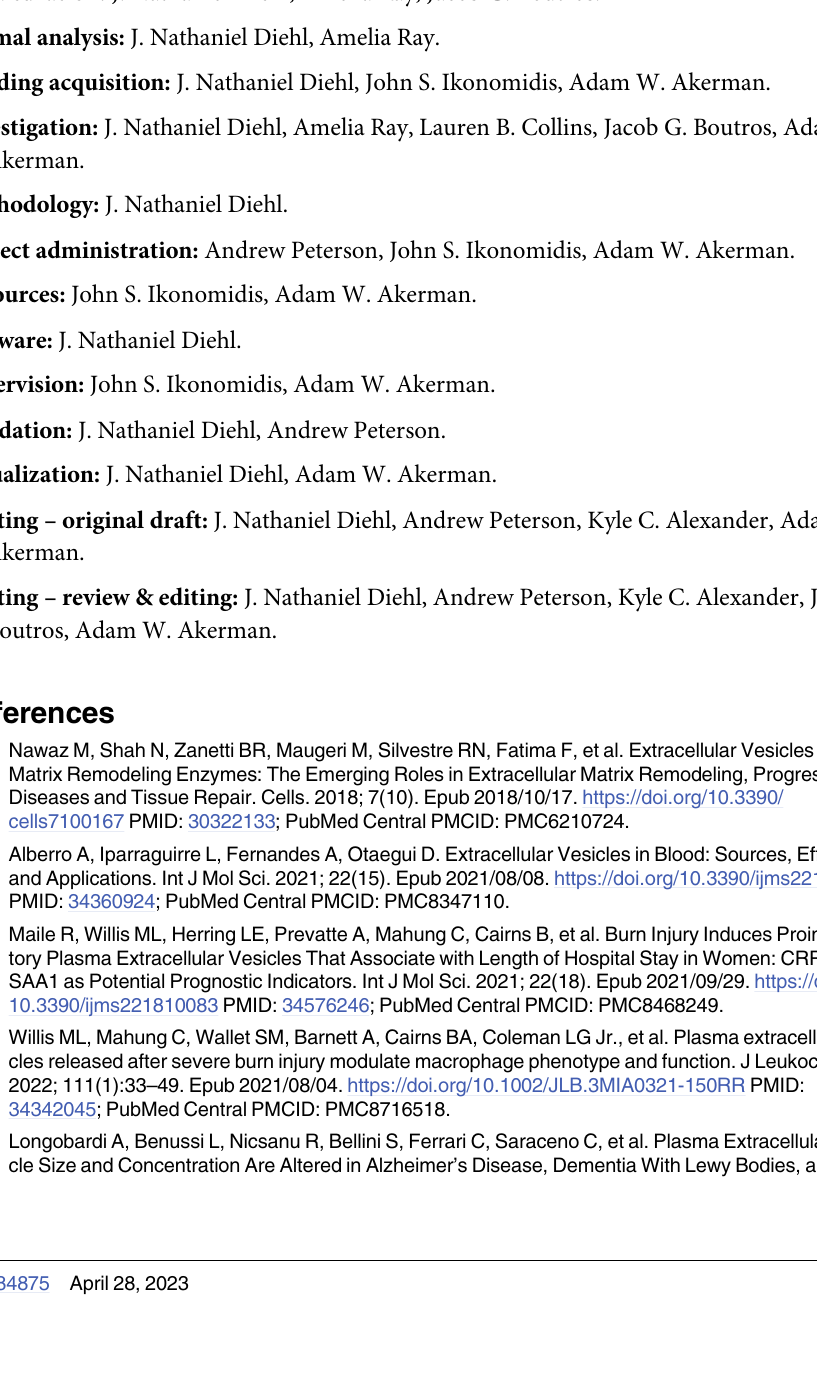
S1 Table. Formatted TRPS data output. Data table containing TRPS data with technical rep- licates.